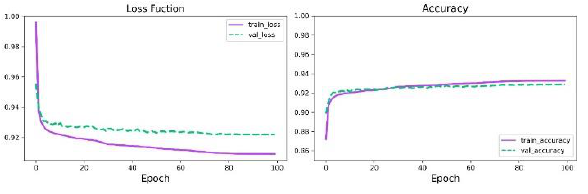
Fig. 5. Learning curve of Loss value and accuracy using